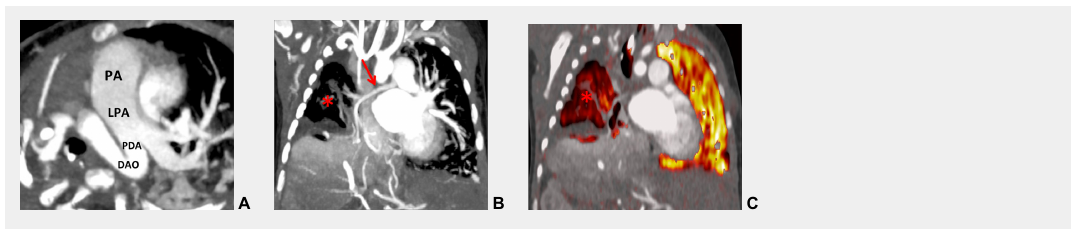
Pulmonary hypertension due to a patent ductus arteriosus (PDA) connecting the descending aorta (DAO) to the left pulmonary artery (LPA) ( A ) in a 2-month-old boy treated for a right diaphragmatic hernia ( B ) resulting in hypoplasia of the right pulmonary artery (arrow). The functional consequences ( C ) are extended hypoperfusion of the right lung (star).